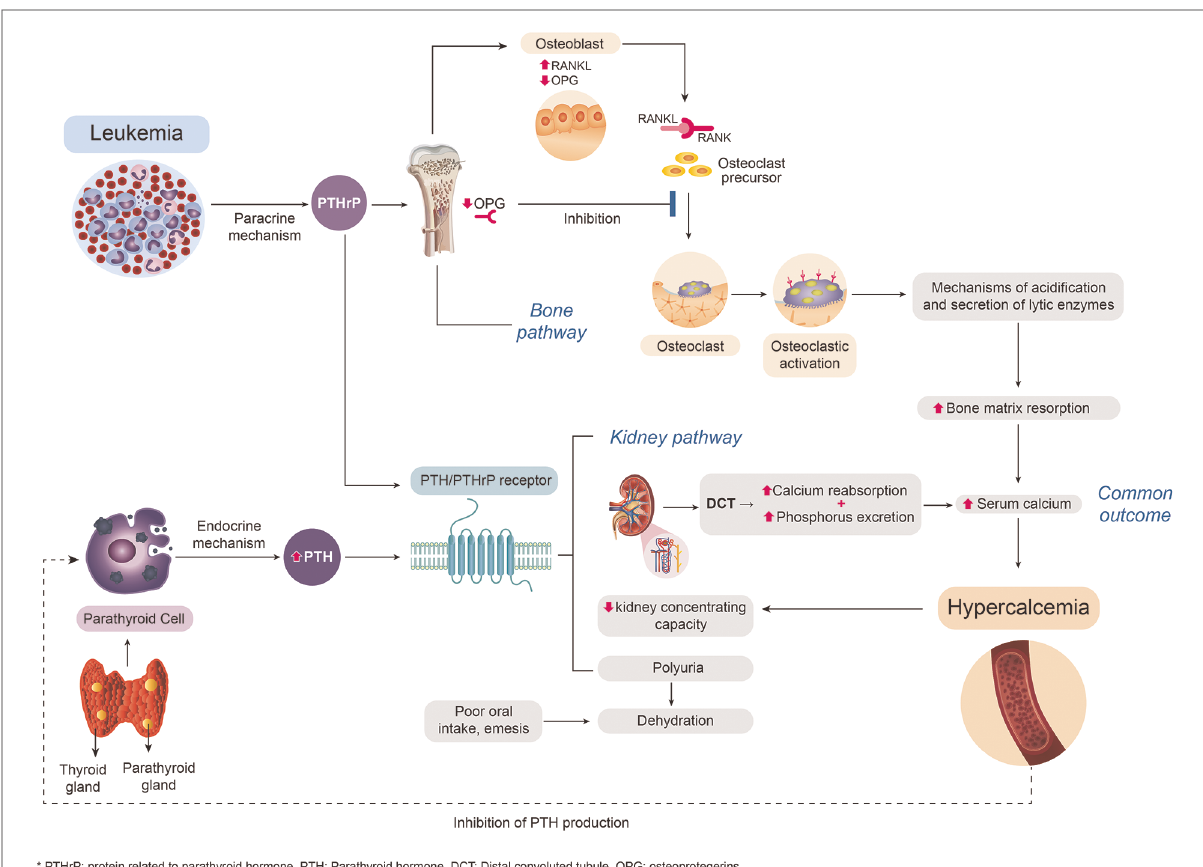
FIGURE 1 Approach to the pathophysiological way to hypercalcemia of malignancy. Design and fl owchart intellectual property by the authors. This image was developed based on the actual related scienti fi c literature. PTHrP, secreted systemically by malignant para-endocrine pathways, shares a close homology with PTH. At the renal level, PTHrP stimulates calcium reabsorption in the distal convoluted tubule (1, 4). Elevated calcium levels have an inhibitory action on the production of PTH by the parathyroid, which explains the abnormally decreased serum levels of PTH. Additionally, patients with hypercalcemia present a compromise of the renal concentration capacity that causes polyuria with volume depletion, which, together with the decrease in oral intake, associated nausea, and emesis, leads to the development of acute renal failure (14). At the bone level, PTHrP stimulates osteoblasts to secrete regulatory hormones such as the ligand of the activating receptor for nuclear factor-kB (RANKL) (12), which binds to the osteoclast membrane receptor favoring signaling pathways, their differentiation, and the resorption of the bone matrix through the generation of mechanisms of acidi fi cation and secretion of lytic enzymes, and inhibits the production of osteoprotegerin (inhibitor of differentiation of osteoclasts), perpetuating the process of bone resorption (15). PTH, parathyroid hormone; PTHrP, parathyroid hormone- related